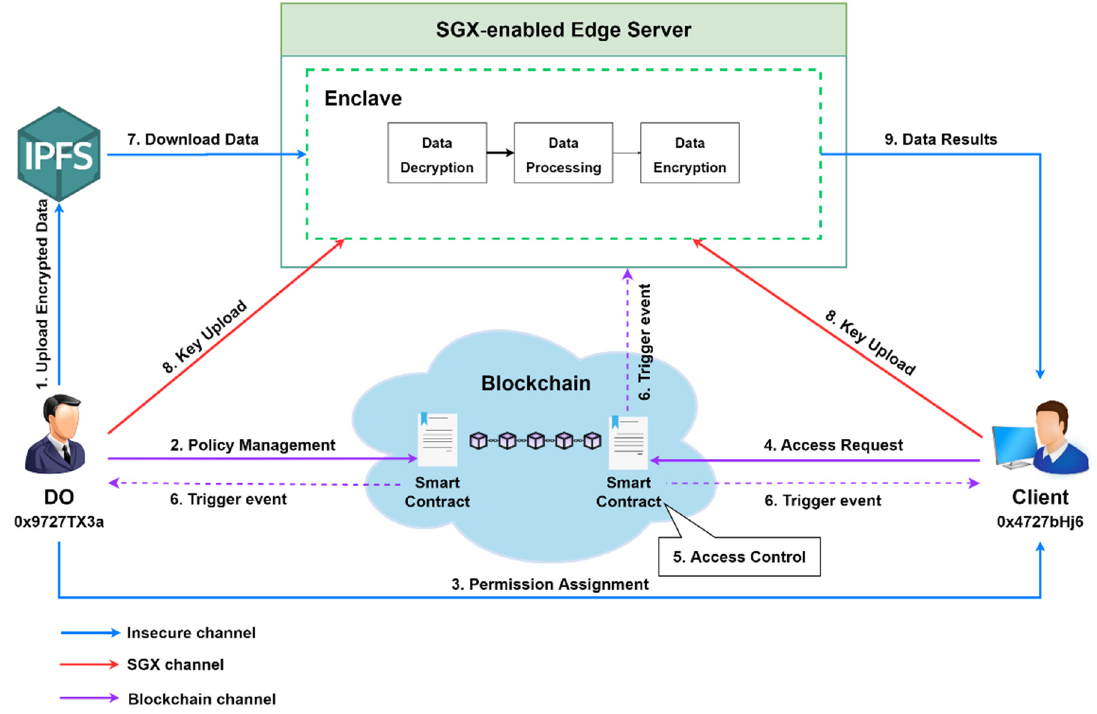
Figure 7. Access and processing flow of IoT data based on SGX edge computing.